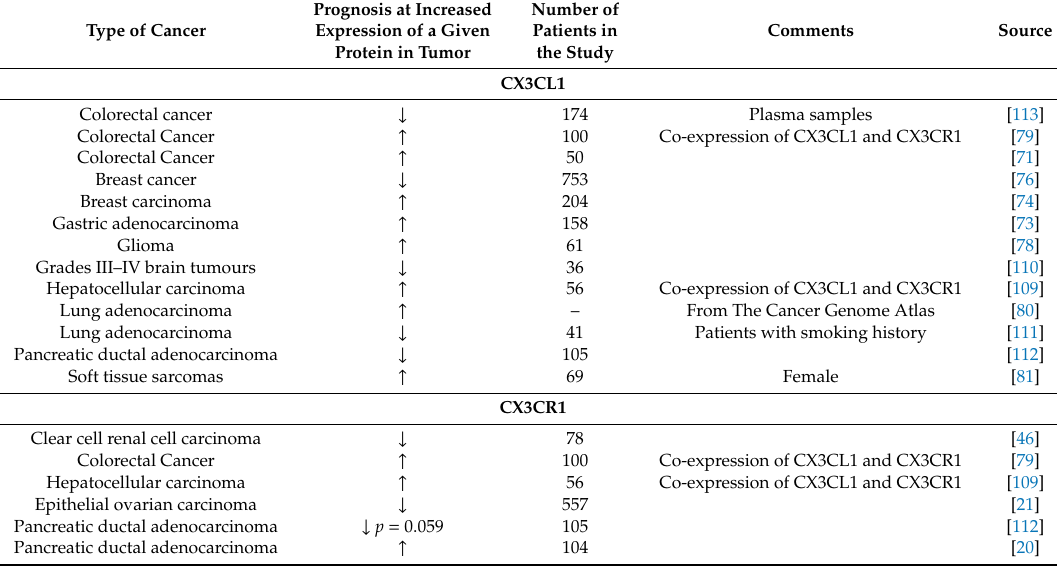
Table 1. Prognosis for various types of cancer with increased expression of CX3CL1 or CX3CR1 according to reports available in